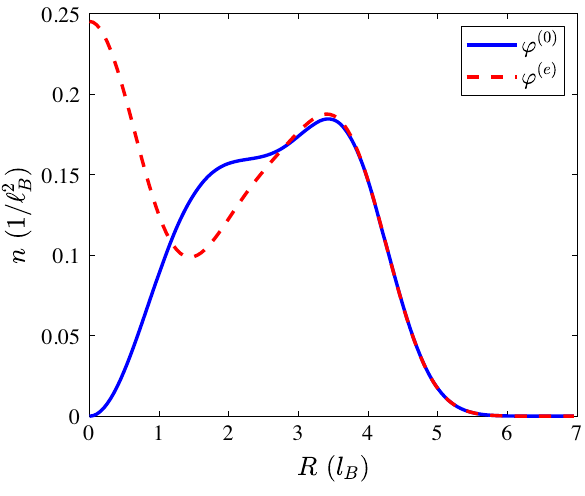
FIG. 8. Density of the ground state φ ð 0 Þ and the first excited state φ ð e Þ as a function of the distance to the quasihole located at R ¼ 0 in the φ ð 0 Þ case. Both curves were calculated for n ¼ 10 particles in the FQH bath and converge with respect to n